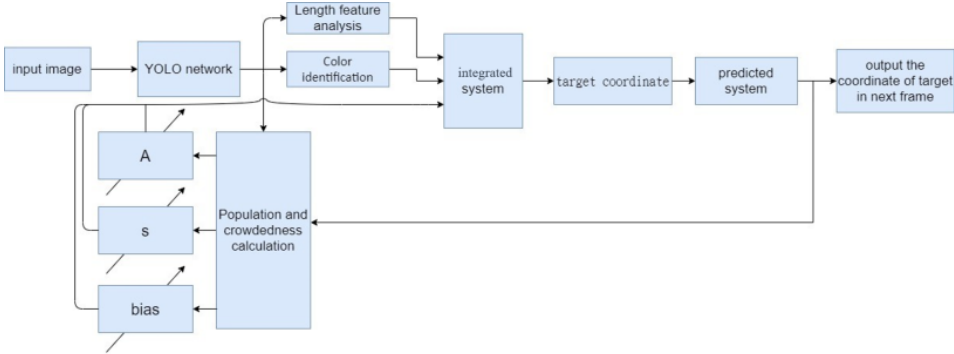
Figure 6. Operational flow of the adaptive target identification system.